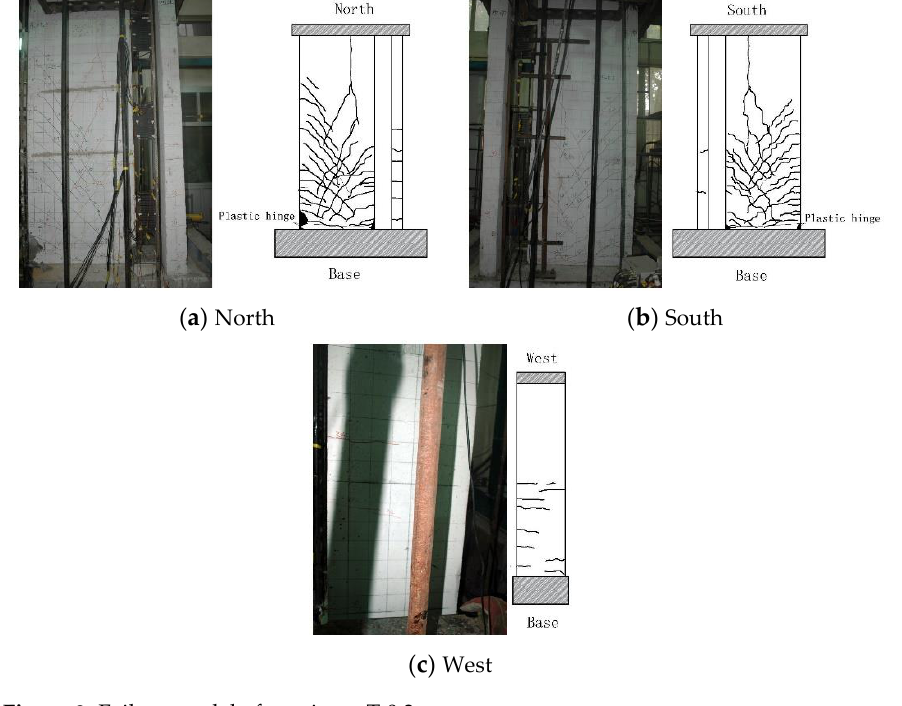
Figure 9. Failure model of specimen T-0.3.